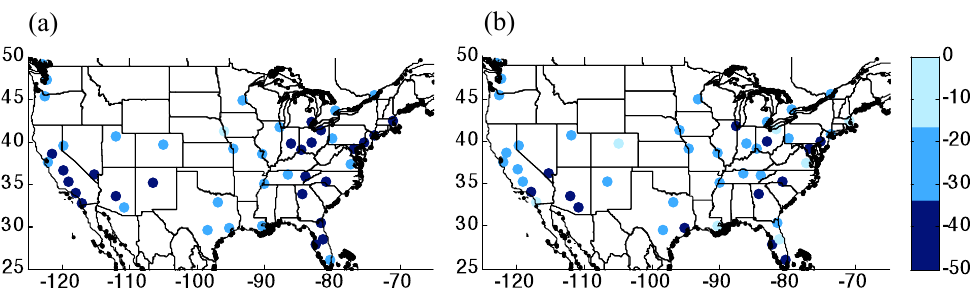
Fig. 6. Percent change in average summertime (April–September) OMI-observed NO 2 column for 2005–2011 for major cities in the US for (a) weekdays and (b)